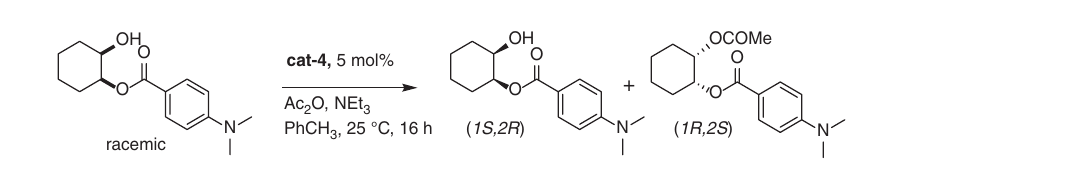
Scheme 7 Preparation of dopamine-l-prolinol catalyst cat-4.